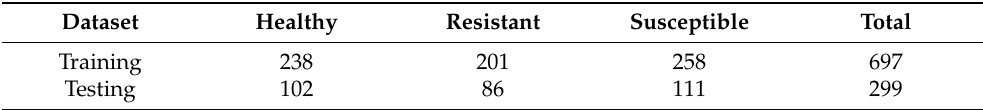
Table 1. Dataset distribution into three